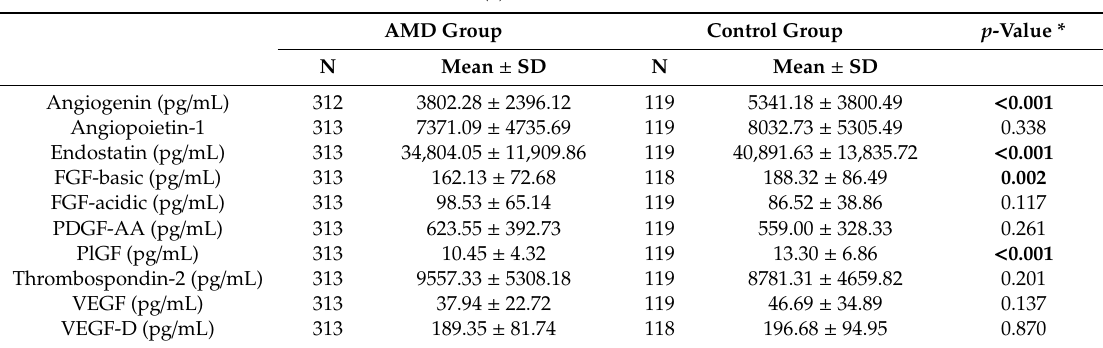
Table 2. ( a ) Comparison of the levels of angiogenesis-regulating factors in AMD patients (both dry and wet) and controls. ( b ) Comparison of the levels of angiogenesis-regulating factors in dry and wet AMD